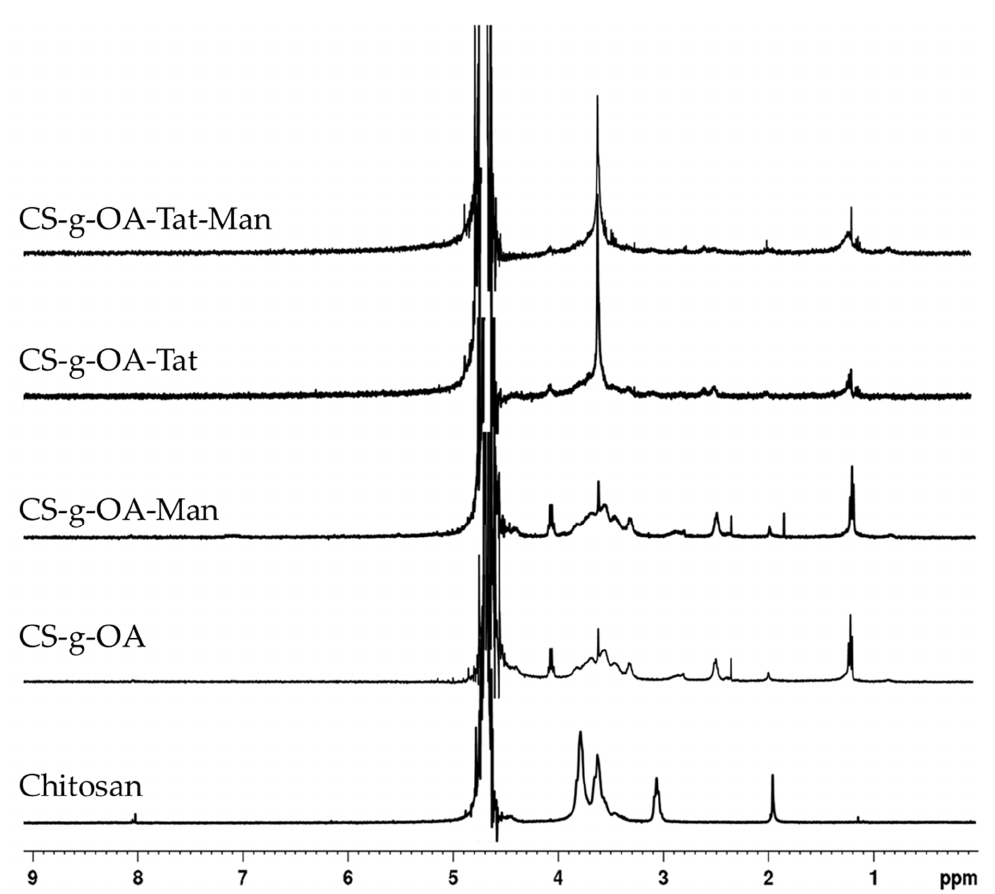
Figure 1. The 1 H-NMR spectra of CS and synthesized OA-g-CS, OA-g-CS-Man, OA-g-CS-Tat, and OA-g-CS-Man-Tat conjugates.